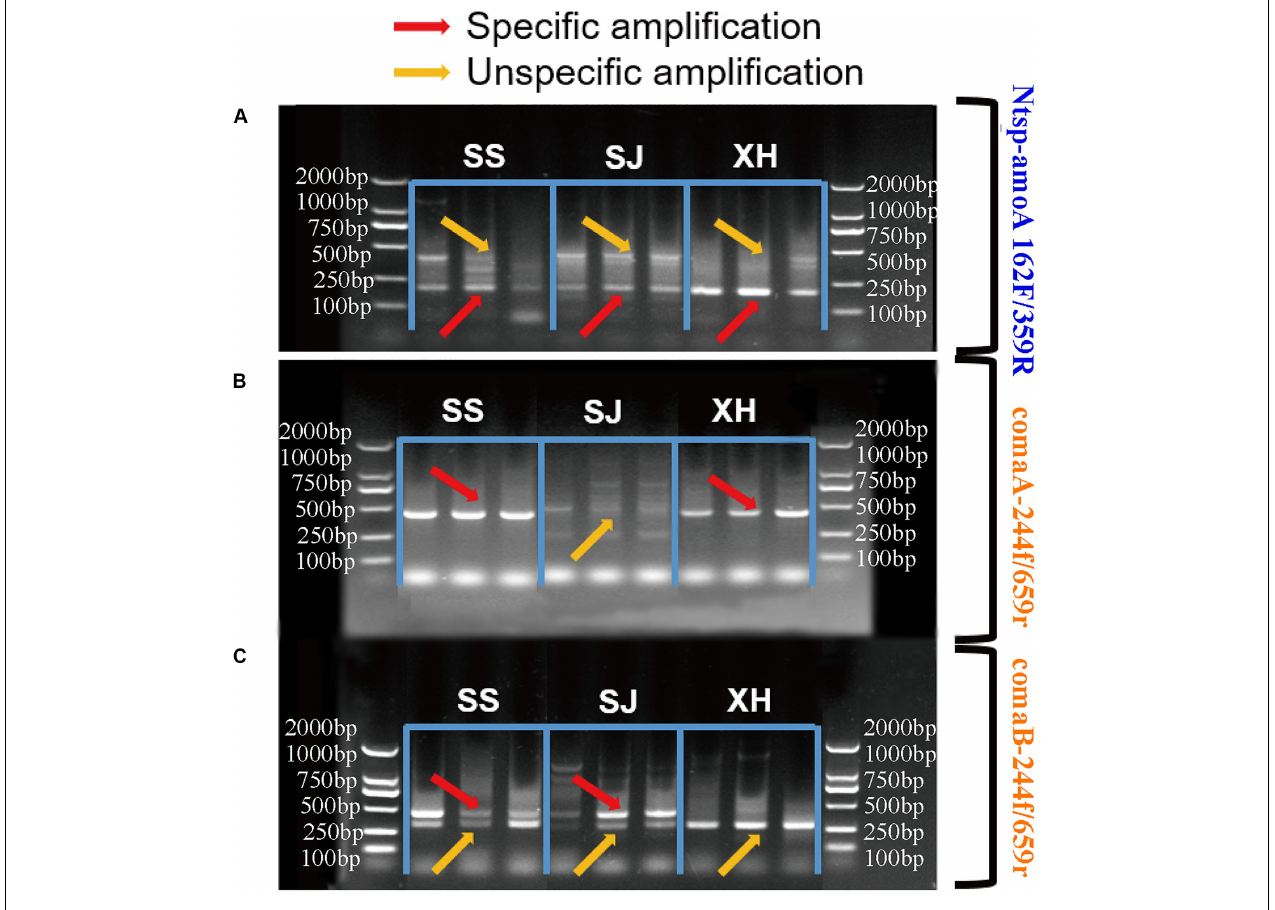
FIGURE 2 | Agarose gel electrophoresis of PCR amplification products (A) with primer sets Ntsp-amoA 162F/359R, (B) comaA-244f/659r and (C) comaB-244f/659r in SS (Sangsang), SJ (Sanjiang) and XH (Xianghai) wetland soil samples. The red and yellow arrows represented specific amplification and non-specific amplification,